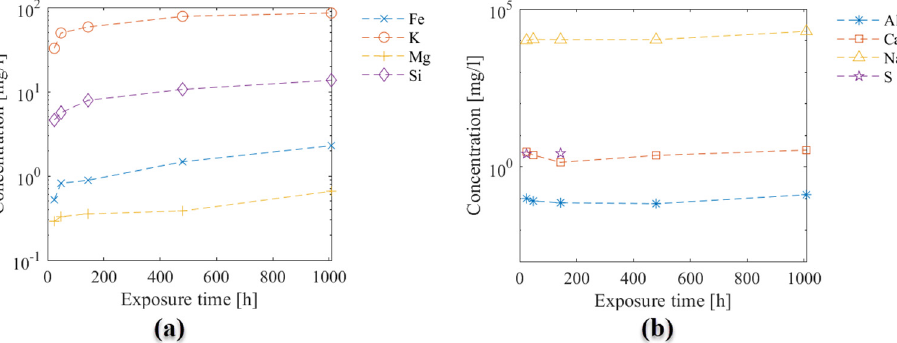
Figure 4. Elemental composition of the exposure solution over time, measured by ICPOES. ( a ) Fe, K, Mg, and Si; and ( b ) Al, Ca, Na, and S, on a different y-scale. Note that Sulphur data are incomplete, and the Al data are around the detection limit.